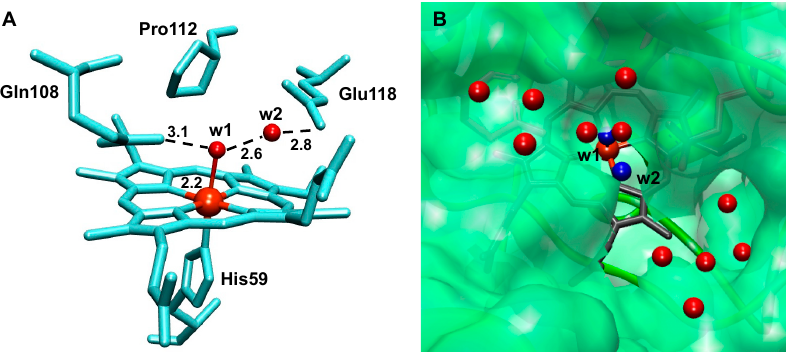
Figure 6. Structure of the P heme active site in chain A. ( A ) In the active site, there are two water molecules, w1 and w2 (small red spheres representing their oxygen atoms), at a short distance from the conserved Gln108 and Glu118 side chains. ( B ) The surface above the P heme pocket showing a channel of waters above w1 and w2 (here as blue spheres). The water molecules around this pocket are represented as red spheres occupying small pockets and groves around the entrance. Figures